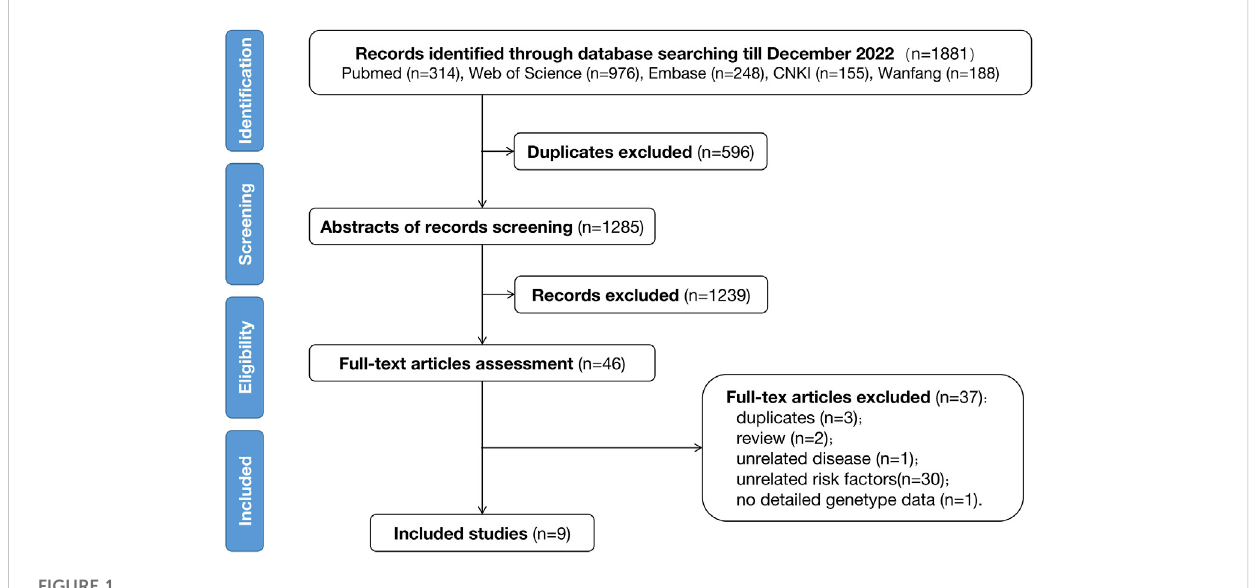
FIGURE 1 Flow diagram of the study selection